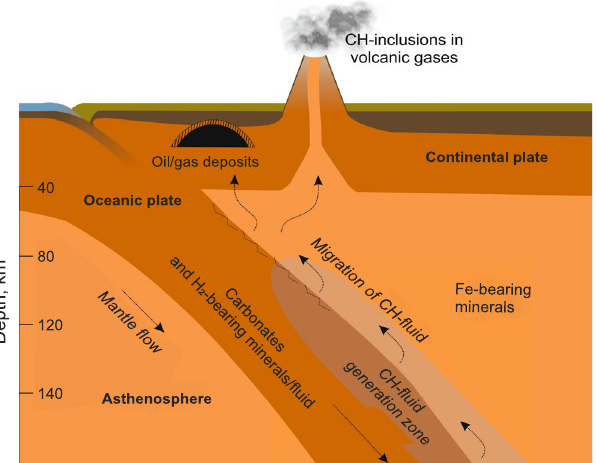
Figure 3. Schematic representation of the generation and migration of a hydrocarbon fluid during